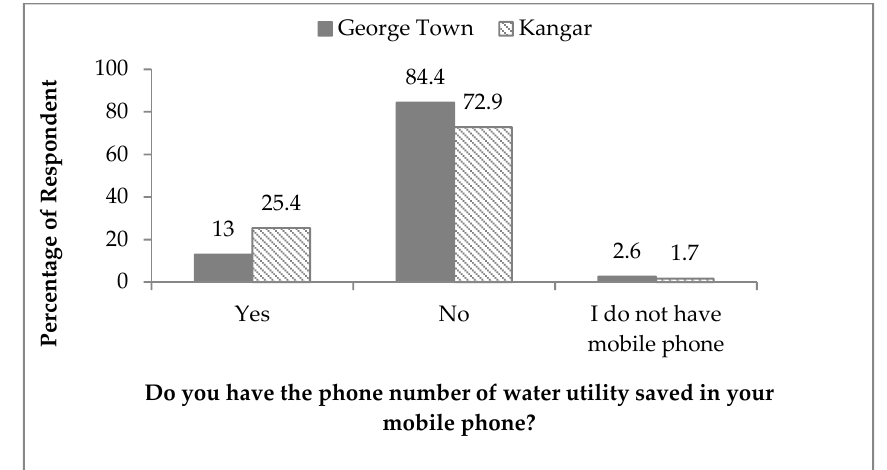
Figure 6. Behaviour towards pipe leaking or pipe burst issue.